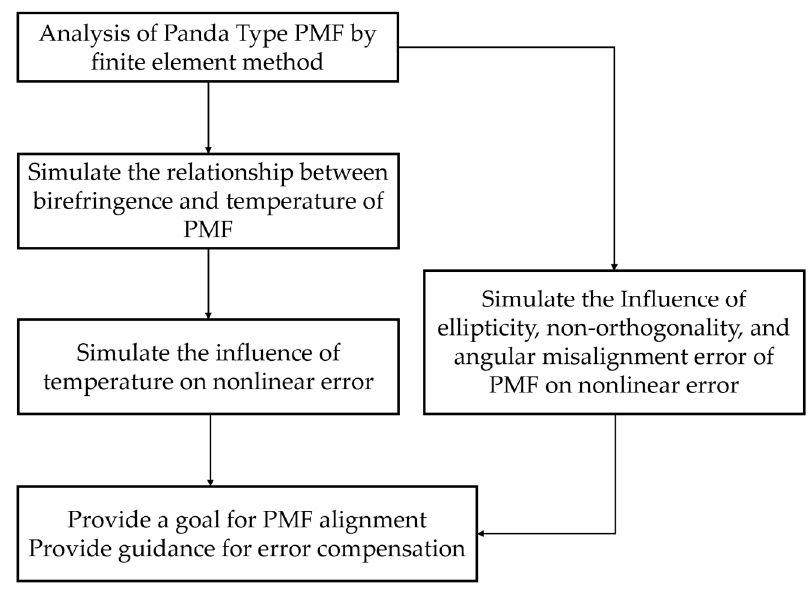
Figure 3. Nonlinear error simulation analysis flowchart.